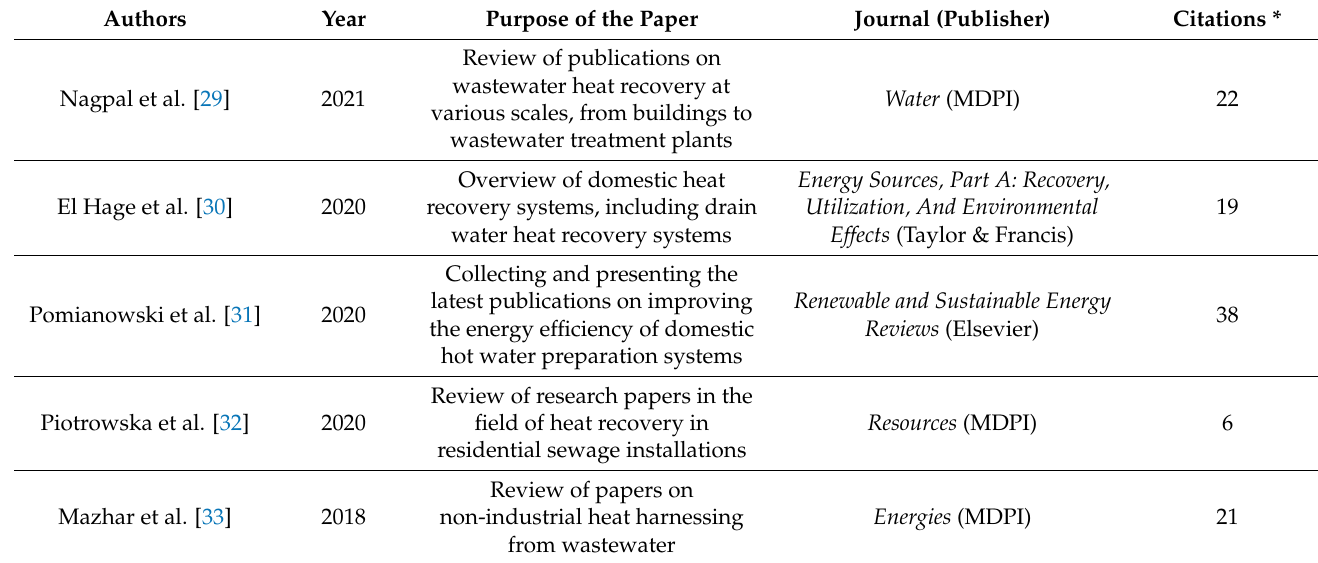
Table 1. Review papers in greywater energy recovery domain.